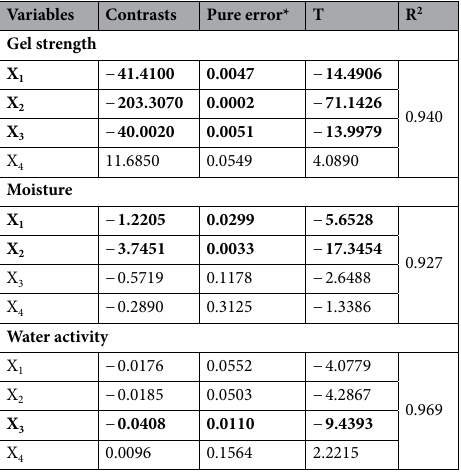
Table 5. Estimated contrasts of variables, t coefficient, and statistical significance in the fractional design. *p ≤ 0.05. X 1 : Oven time (h); X 2 : Oven temperature (°C); X 3 : Infrared temperature (°C); X 4 : Infrared time (h). The values marked in bold indicate the variables that showed significant effects on the drying